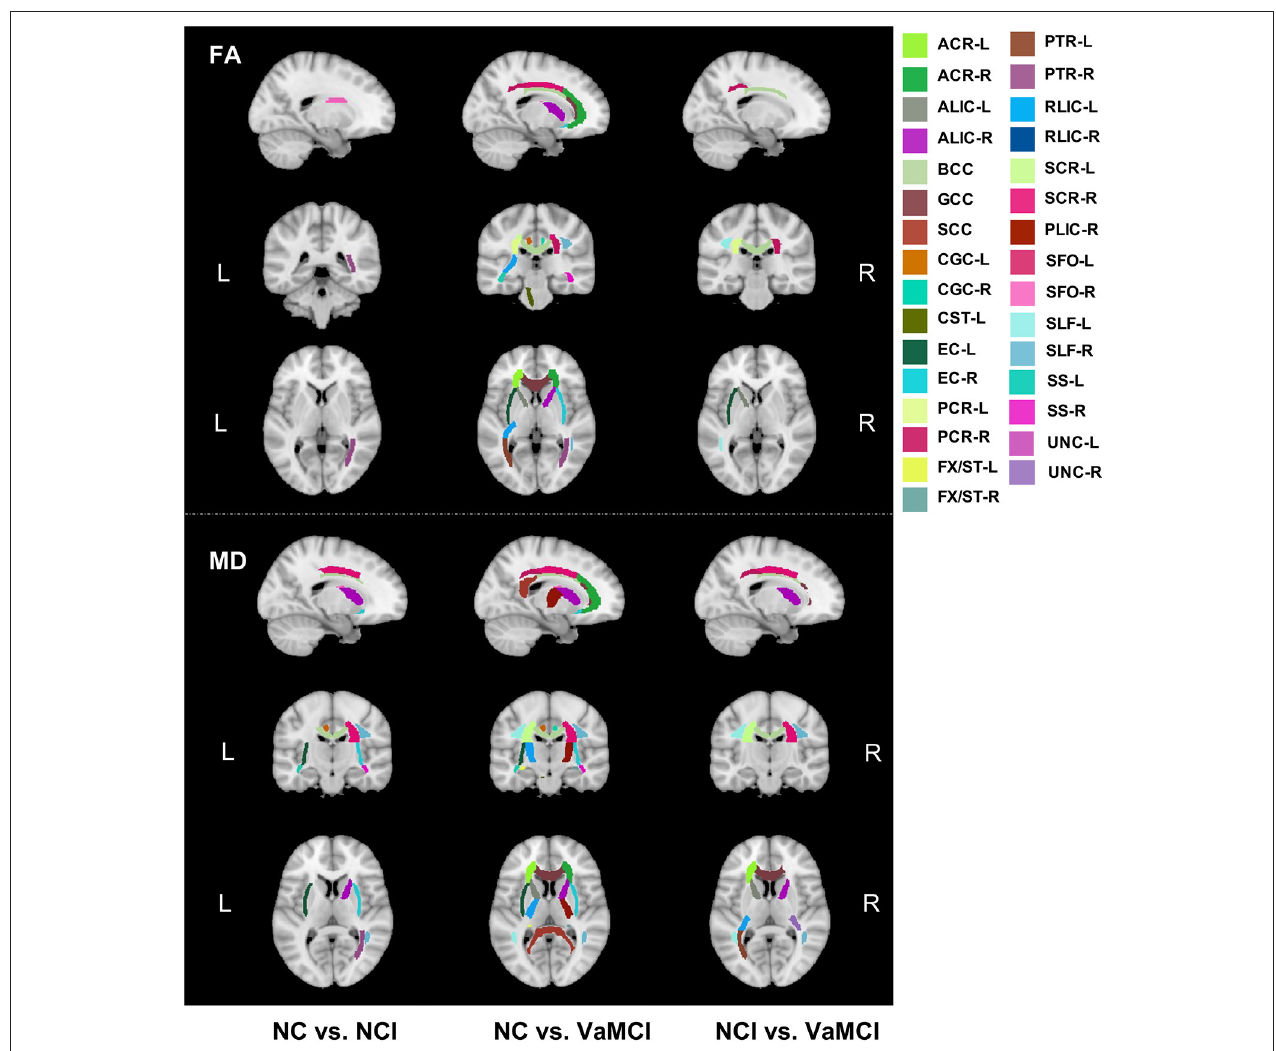
FIGURE 3 | Group comparison results of ROI analysis for 42 white matter tracts. Group comparison of FA and MD on regional white matter tracts. Upper panels show the FA difference between every two groups, and lower panels show the MD results between every two groups. FA, skeletonized fractional anisotropy; MD, skeletonized mean diffusivity, VaMCI, CSVD with mild cognitive impairment; NCI, CSVD with no cognitive impairment; NC, normal